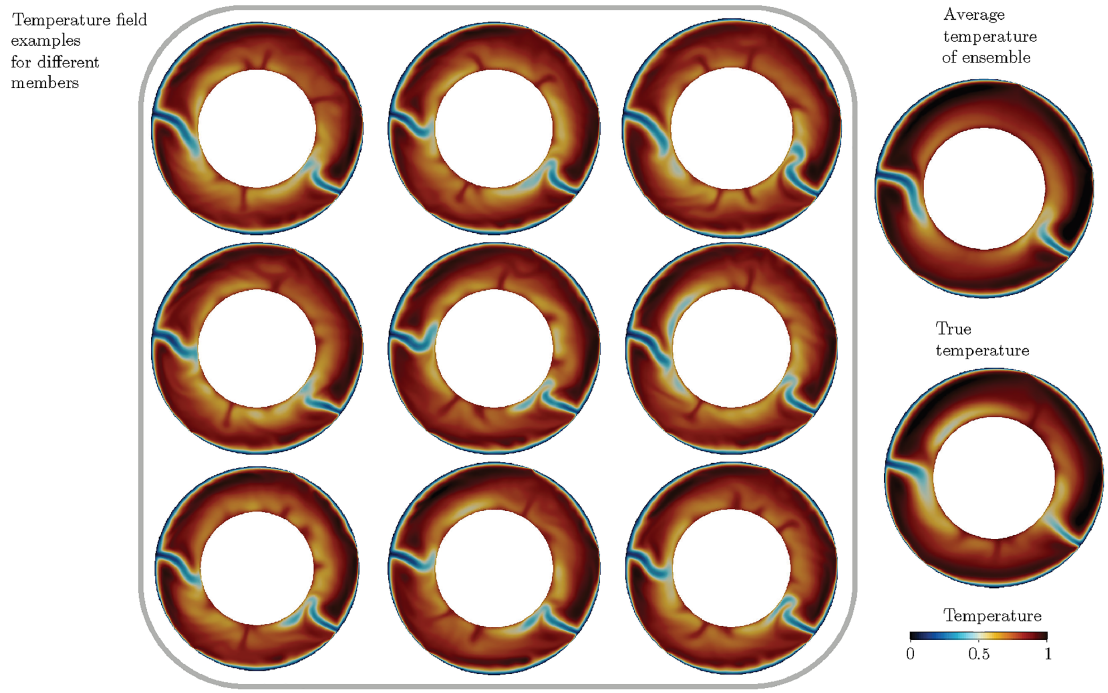
Figure 5. Example of temperature fields of the members of the ensemble. This example is taken after 80Myr for the assimilation of evolu- tion B, with EnKF N = 288, (cid:96) v = 0 . 7 and (cid:96) h = π/